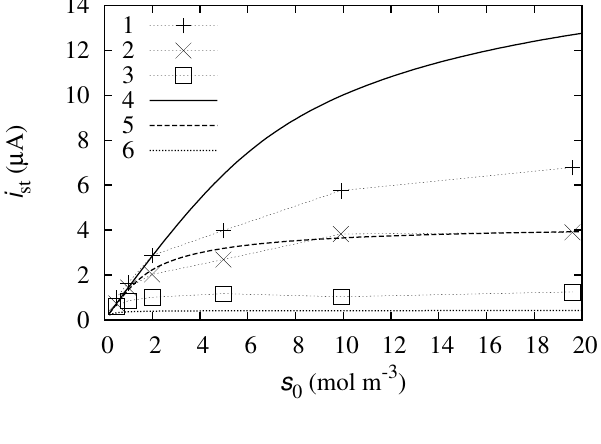
Experimental (1, 2, 3) and computational (4, 5, 6) calibration curves at different concentrations of the mediator ( m ): 0 . 2 mol/m 3 (1, 4), 0 . 05 mol/m 3 (2, 5), 0 0 . 005 mol/m 3 (3,